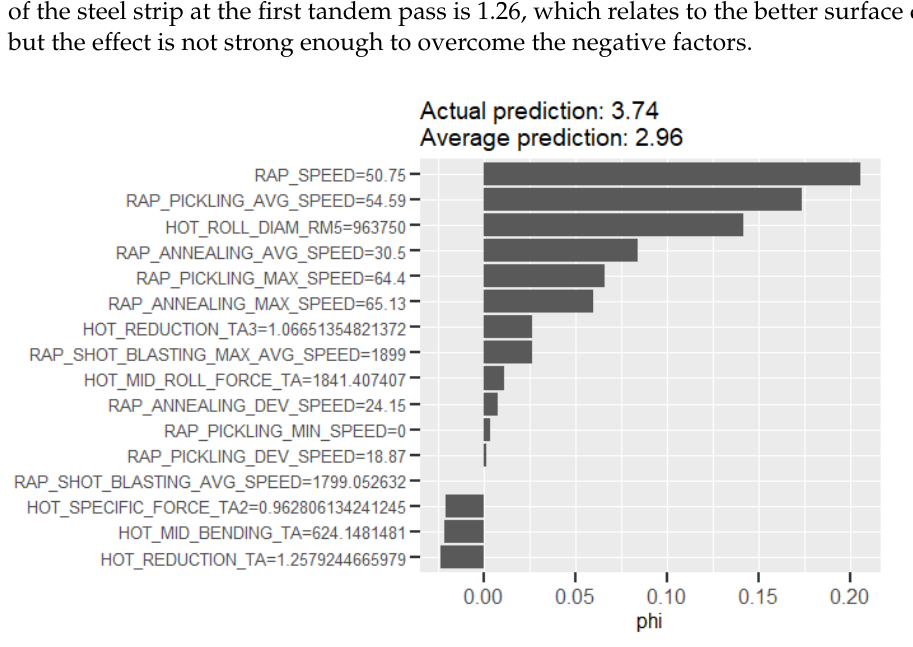
Figure 16. SHAP values for a bad product with a prediction of 3.74 for roughness, while the average prediction is 2.96 inside the group of the same steel